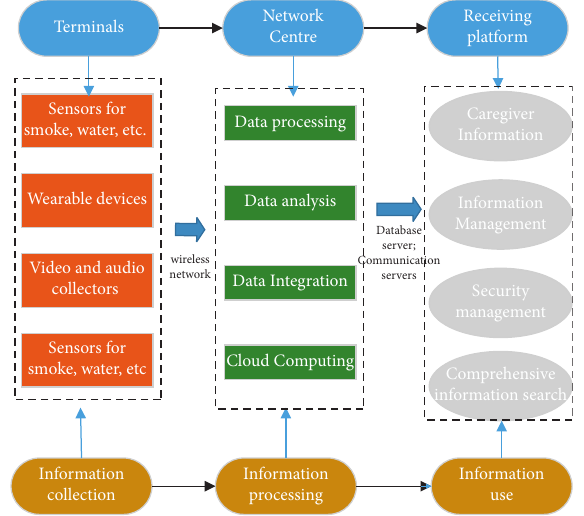
Figure 6: Design of the service platform for “Internet+”